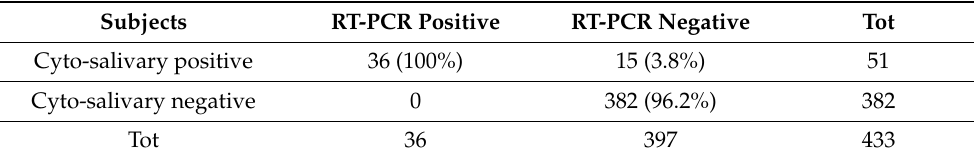
Table 1. Results of the screening of the new cyto-salivary antigen test compared with RT-PCR in asymptomatic subjects for SARS-CoV-2 detection.